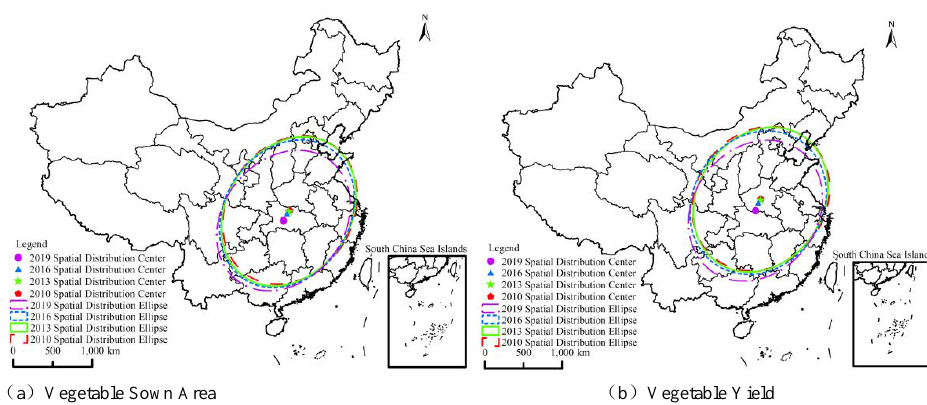
Figure 4 Figure 4. Standard deviation ellipse of vegetable-sown area and yield in China: ( a ) vegetable-sown area; ( b ) vegetable